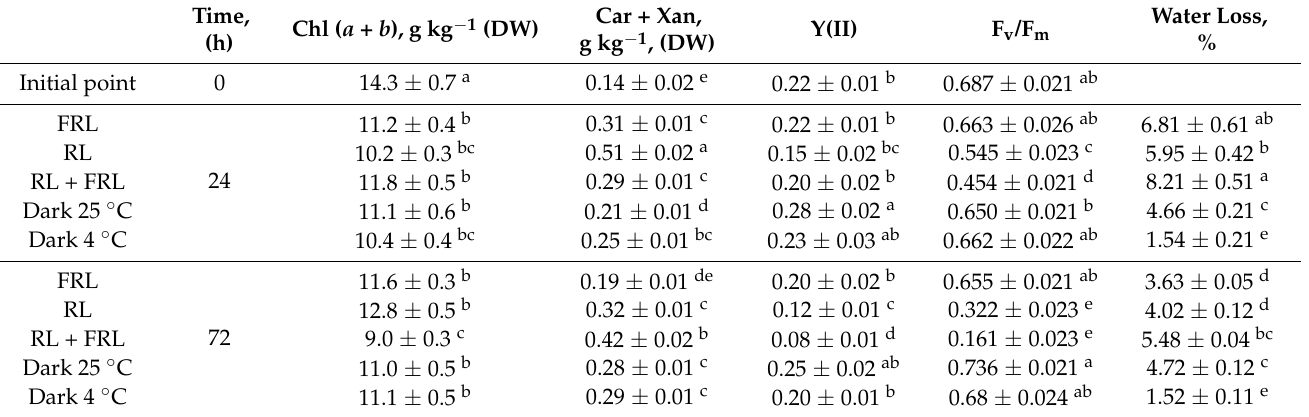
Table 1. The content of the sum of chlorophylls, carotenoids, and xanthophylls, water loss (%), and indicators of the maximum and effective quantum yield of PSII under the influence of RL, FRL, and low temperature in C. annuum fruit after 24 and 72 h.